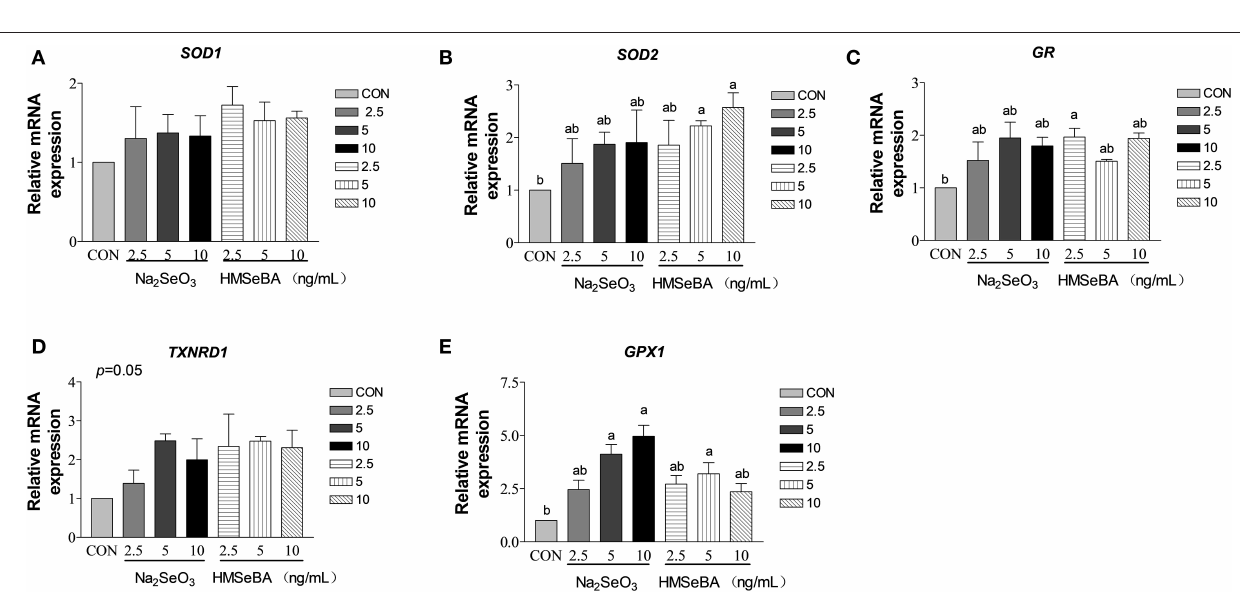
FIGURE 8 | Effects of selenium from different sources and concentrations on the oxidative stress relative gene expression in granulosa cells in vitro. Relative gene expression of (A) SOD1 , (B) SOD2 , (C) GR , (D) TXNRD , and (E) GPX1 in the granulosa cells in vitro . Data are expressed as means values and standard error. a,b Mean values with different superscript letters were significantly different ( P < 0.05). CON: basal media, Na 2 SeO 3 2.5, 5 and 10 ng Se/ml, HMSeBA 2.5, 5, and 10 ng Se/ml; SOD1 , superoxide dismutase 1; SOD2 , superoxide dismutase 2; GR , glutathione reductase; TXNRD , thioredoxin reductase; GPX1 , glutathione